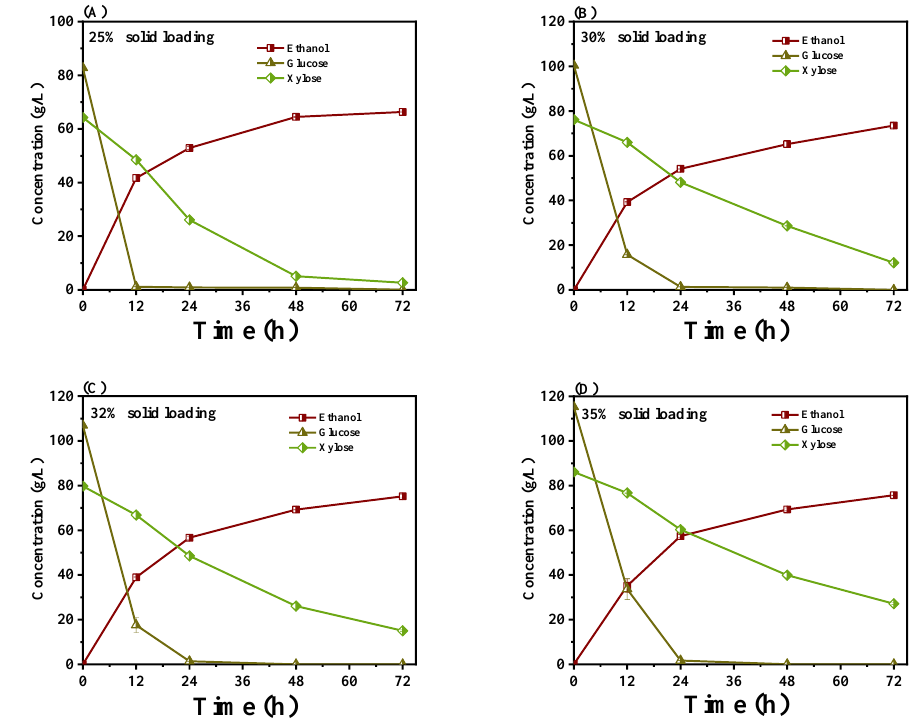
Figure 4. Ethanol fermentation in hydrolysates of DLCA(sa)-CC at 25% ( A ), 30% ( B ), 32% ( C ), and 35% ( D ) solid loading. S. cerevisiae CRD5HS (initial OD 600 = 2) was used for fermentation at pH 5.5, 30 °C, 150 rpm for 72 h.